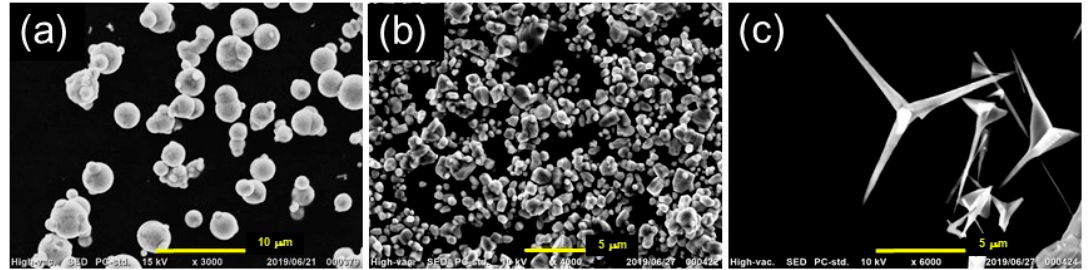
Figure 2. Scanning electron microscope (SEM) photographs for ( a ) magnetic particles, ( b ) nonmagnetic particles (irregular shape), and ( c ) nonmagnetic tetrapods.